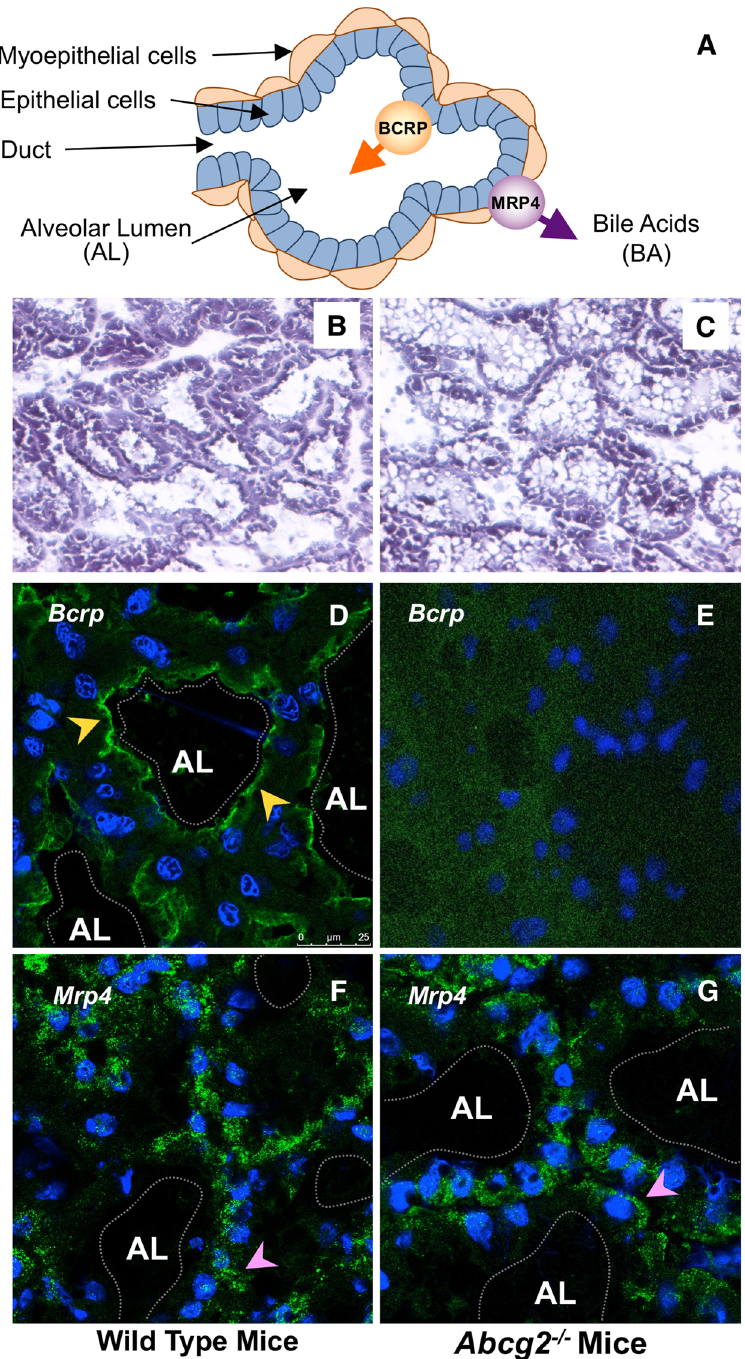
Figure 3. Schematic drawing of the mammary gland secretory unit ( A ). Representative images of histological sections of mammary gland tissue obtained from lactating mice on day 10 after delivery. Hematoxylin/eosin staining (original magnification: 20x) ( B , C ) and immunofluorescence analysis of Bcrp ( D , E ) and Mrp4 ( F , G ) were performed on mammary gland tissue obtained from lactating wild-type ( B , D , F ) and Abcg2 − / − ( C , E , G ) mice. Arrowheads show the apical and basal localization of Bcrp (yellow) and Mrp4 (pink), respectively. AL: alveolar